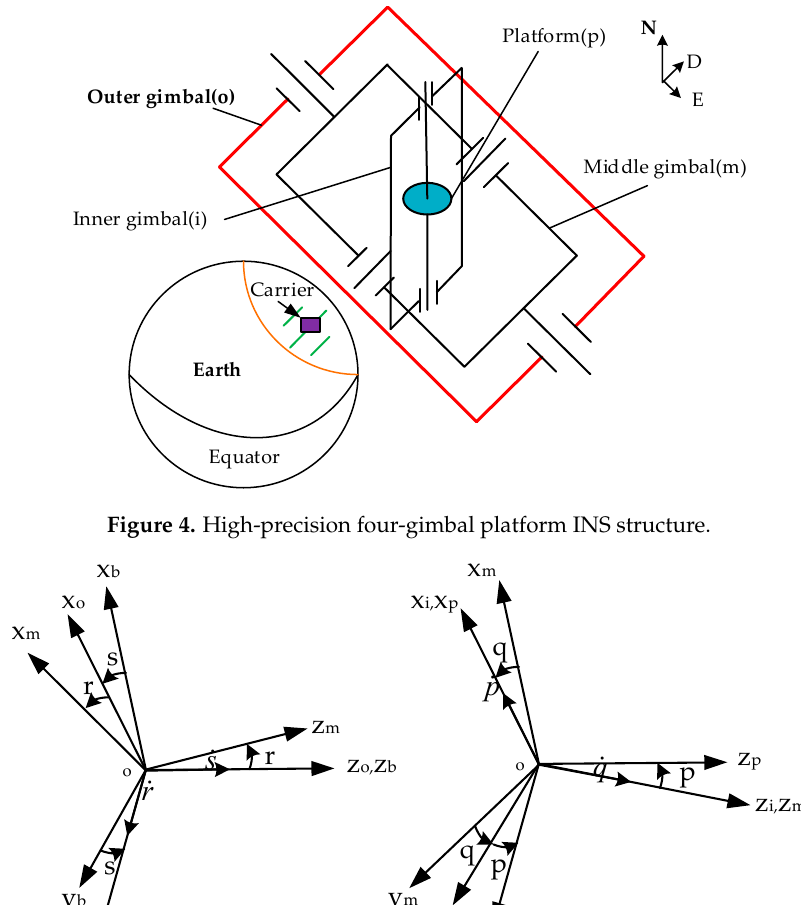
Figure 5. Four-gimbal platform coordinate system definition [37].